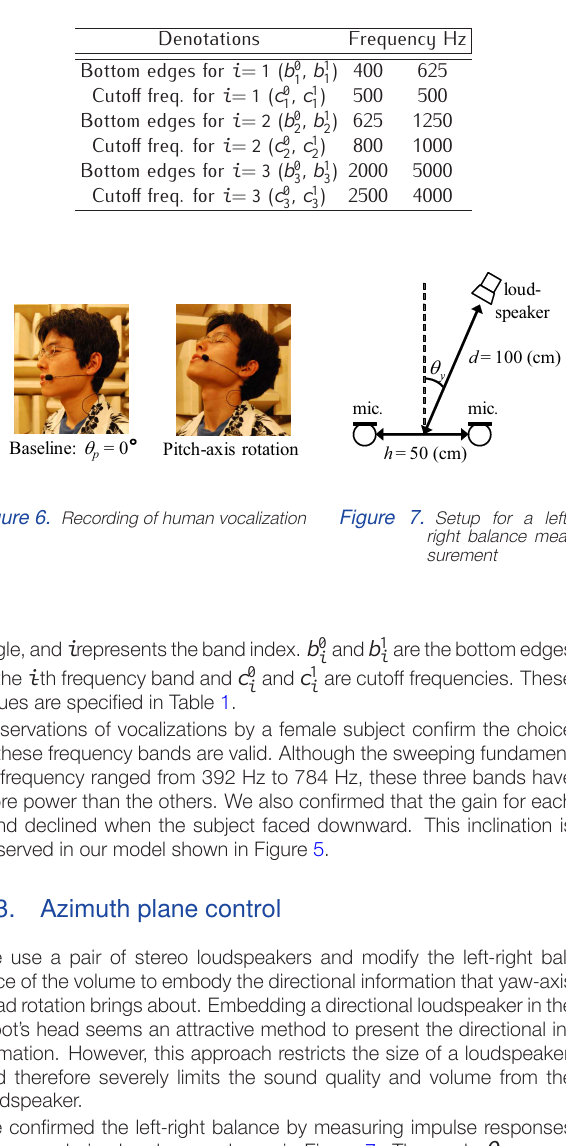
Table 1. Edges of frequency bands Denotations